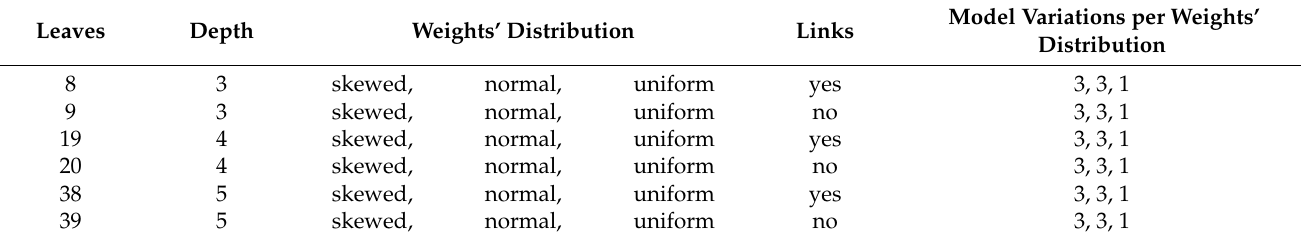
Table 1. Properties of the benchmark DEX decision